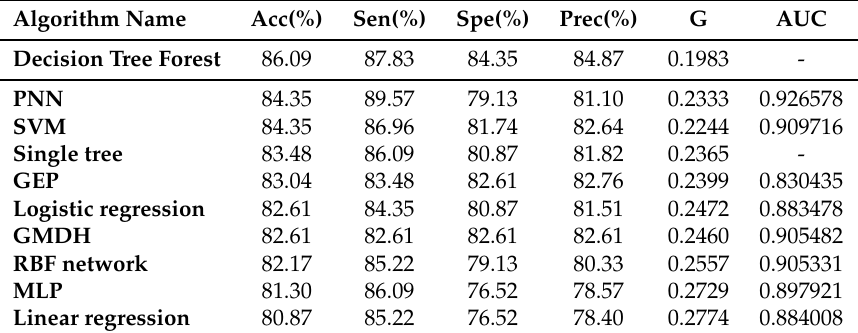
Table 4. The accuracy, sensitivity, specificity, precision, goodness index, and the area under the receiver operating characteristic curve obtained for the set of physical activity variables.